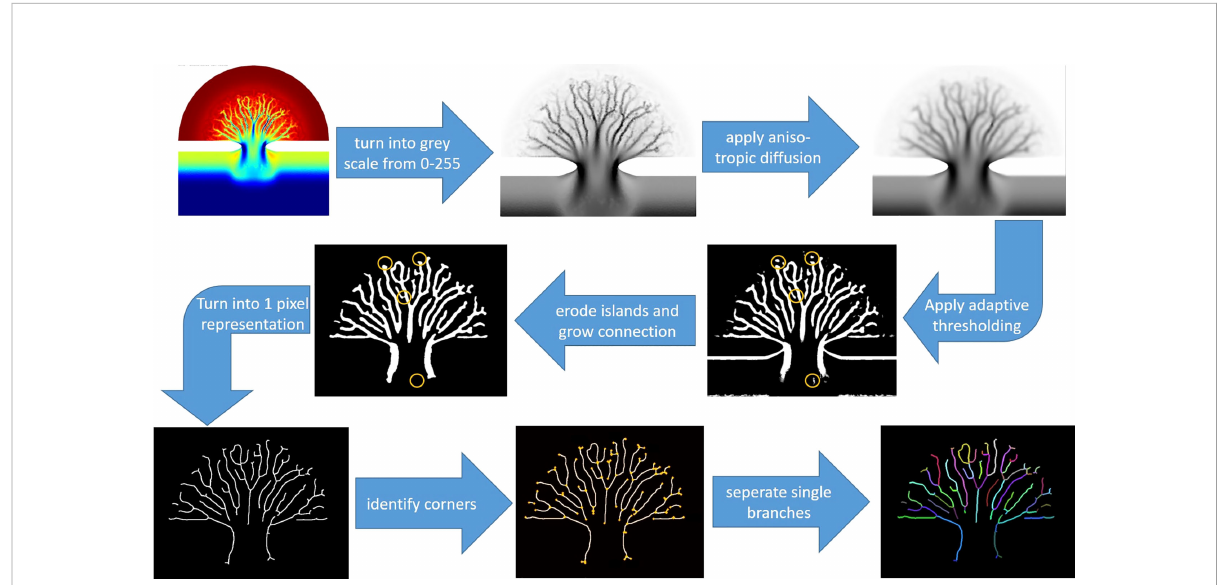
FIGURE 3 A step-by-step procedure of the channel extraction method is shown starting from a color image leading to the identi fi cation and extraction of all channel branches. The python library OpenCV is utilized.